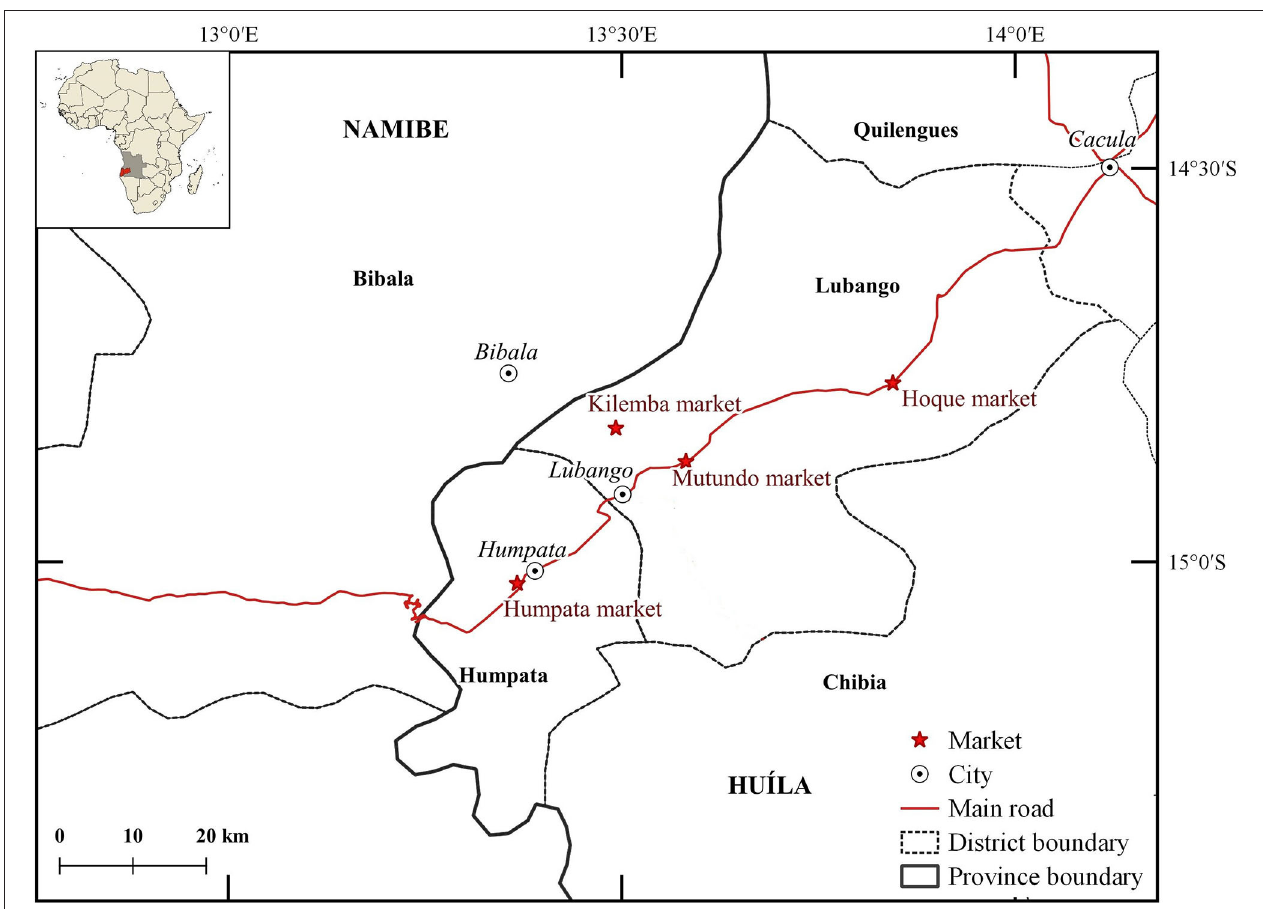
FIGURE 1 | Study site, at Huíla Province, Southern